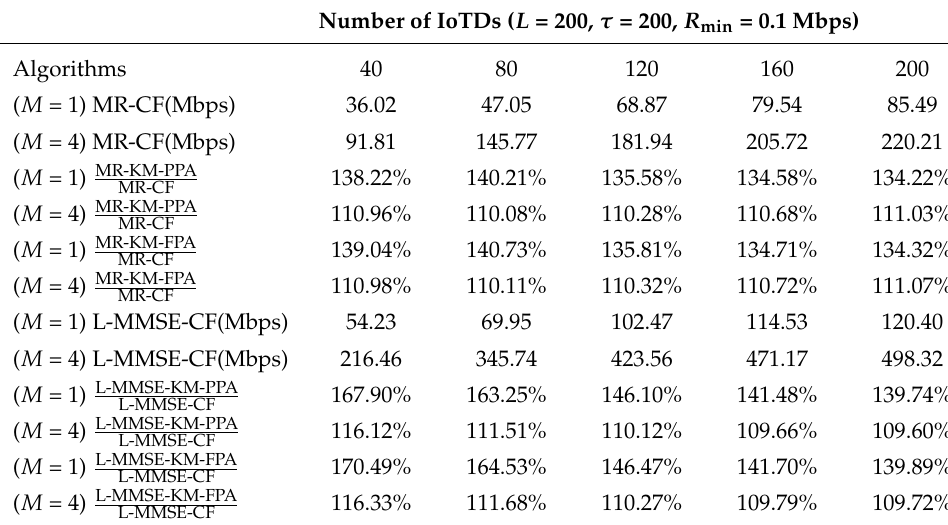
Figure 9. The power consumption versus the number of IoTDs. Table 4. The sum rates of IoTDs with different numbers of